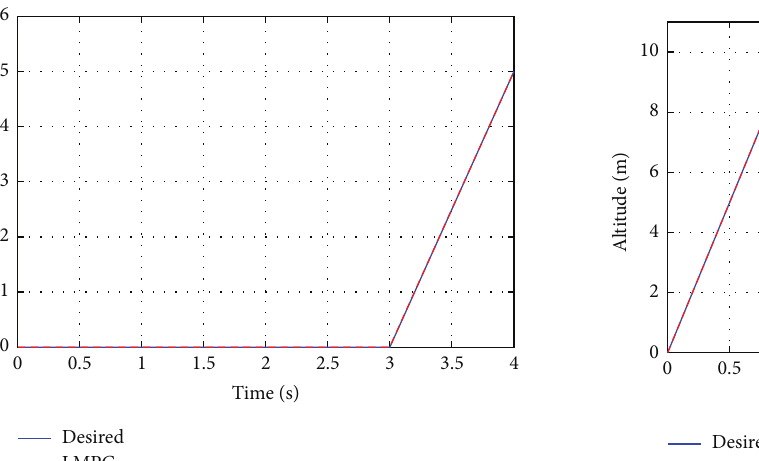
Figure 12: 𝑧 trajectory 𝑁 = 1 .